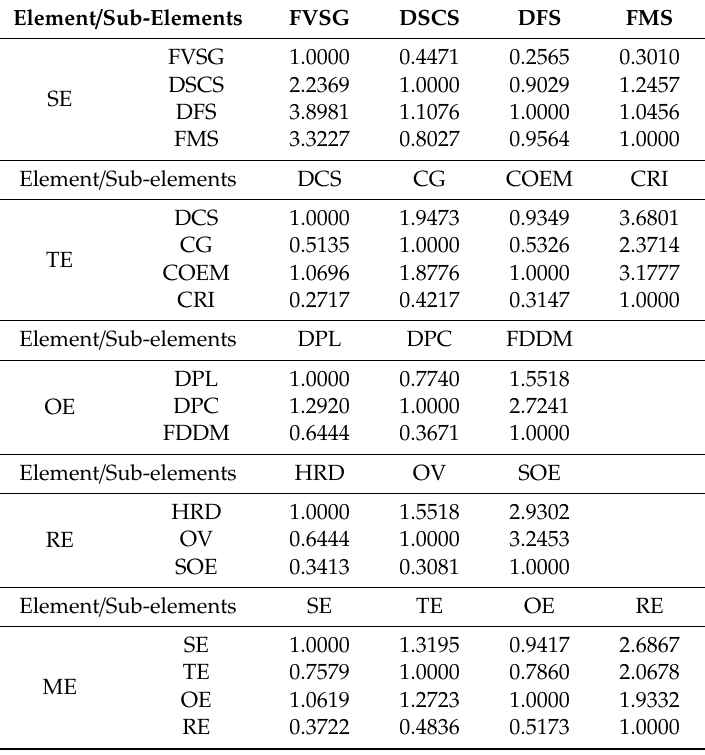
Table 8. Collective judgement in decision